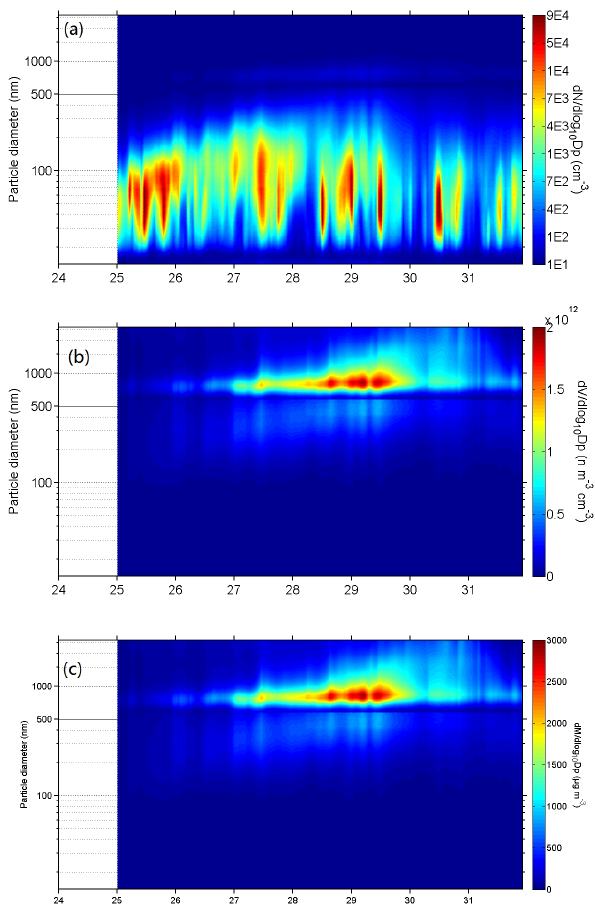
Figure 5. Time series of (a) particle number-size distribution, (b) particle volume size distribution, (c) particle mass-size distri- bution between 14.1 and 2458nm using SMPS combined with APS from 25 to 31 January. The x axis represents the data of January, and the y axis represents particle diameter (nm). The color in pan- els (a–c) represents particle concentration (d N /dlog D p )